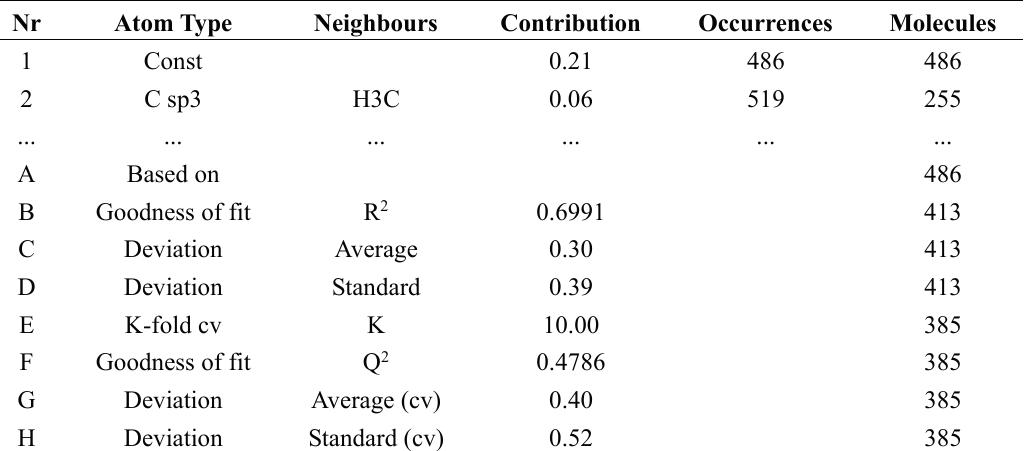
Table 16. Results of the logBB Calculations.